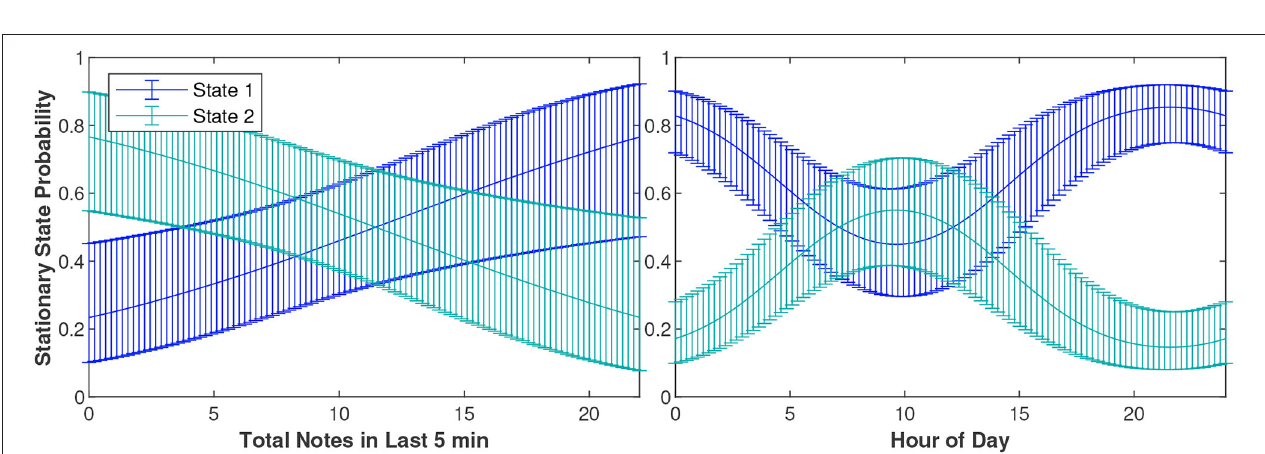
FIGURE 5 | Distributions of the observed variables for the fin whale song tracks normalized by the probability density function. The gray histograms show the observed values normalized by the area of each bar, the blue curves show the probability density function of State 1, the teal curves show the probability density function of State 2, and the black dashed line shows the sum of State 1 and State 2. The kinematic states were estimated using a hidden Markov model.